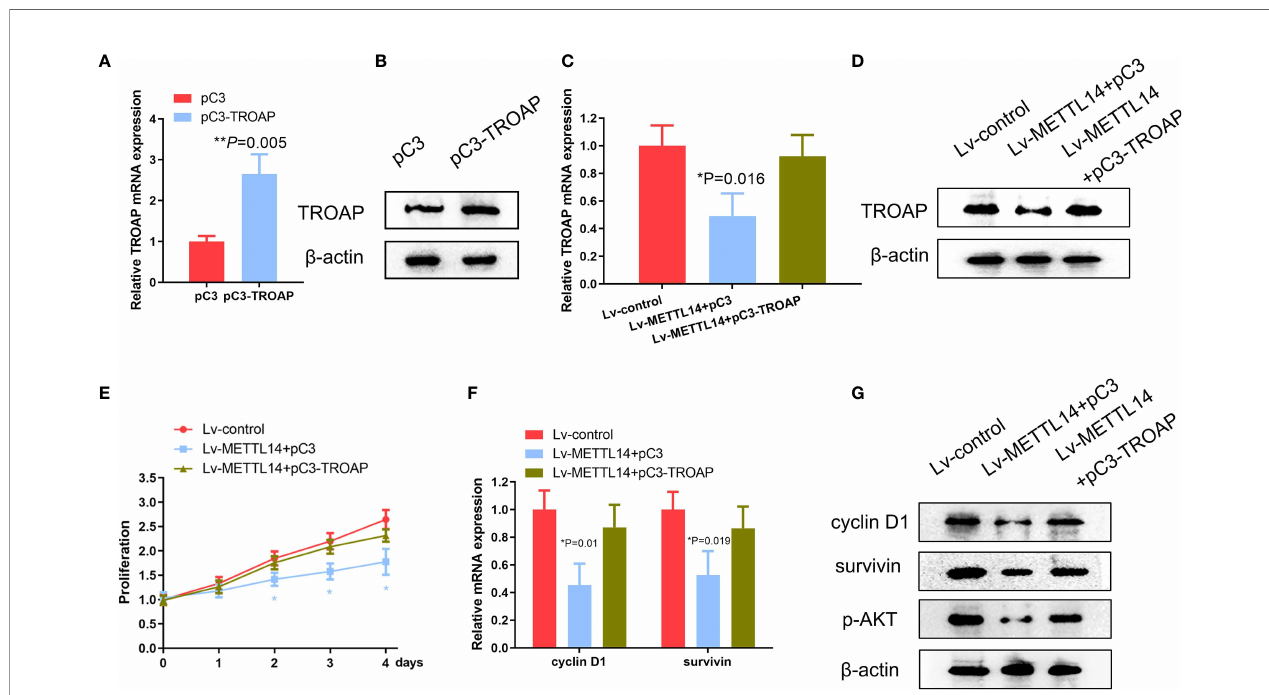
FIGURE 5 | METTL14 suppresses the proliferation of ovarian cancer cell via TROAP. (A, B) TROAP mRNA and protein expression transduced with pC3 or pC3- TROAP (**P=0.005). (C, D) Analyses of TROAP mRNA and protein expression levels in METTL14-overexpressing SKOV-3 cells transduced with pC3 or pC3-TROAP (* P = 0.016). (E) MTS assay of METTL14-overexpressing SKOV-3 cells transduced with pC3 or pC3-TROAP. Values at the indicated timepoints are provided as the mean absorbance with a standard deviation of 6 wells (* P < 0.05). (F) Cyclin D1 and survivin mRNA levels in METTL14-overexpressing SKOV-3 cells with or without TROAP ectopic expression (* P = 0.01, * P = 0.019). Graphical data represented as the mean ± SD. (G) Analysis of expression levels of cyclin D1, survivin, and p-AKT protein by using western